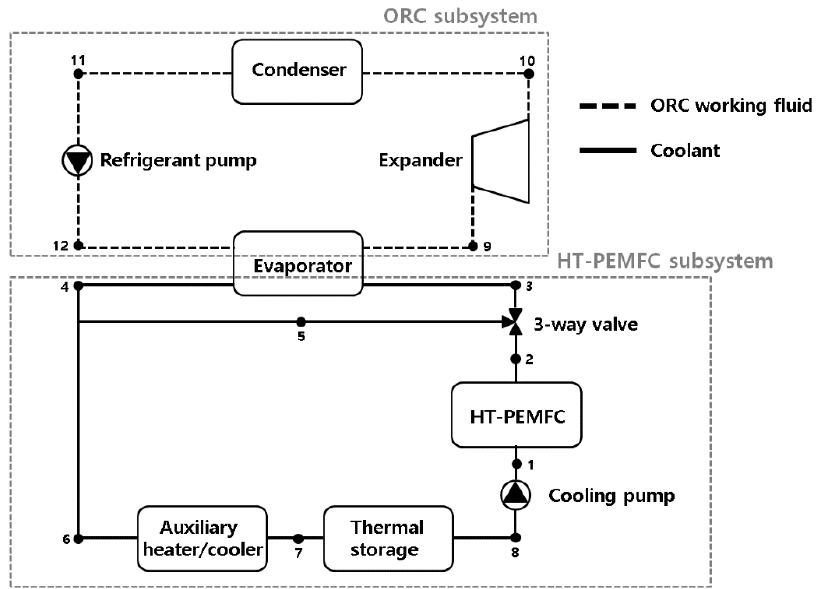
Figure 1. Schematic diagram of combined system.